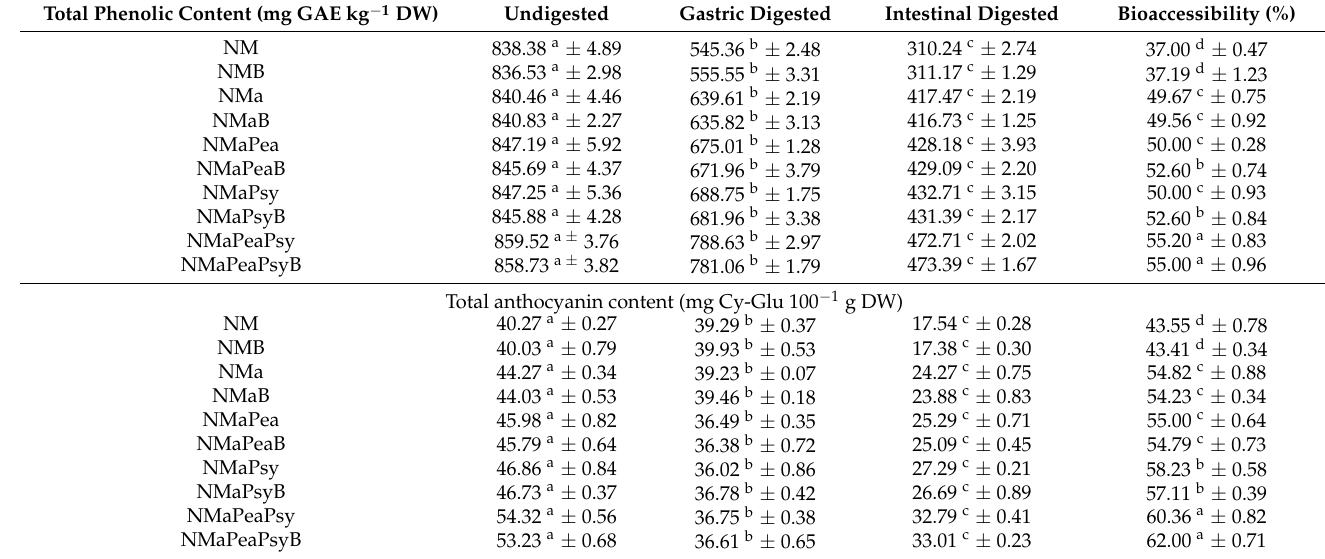
Table 3. An evaluation of the effect of simulated in vitro digestion on the total phenolic, total anthocyanin content of Natal plum ( Carissa macrocarpa )